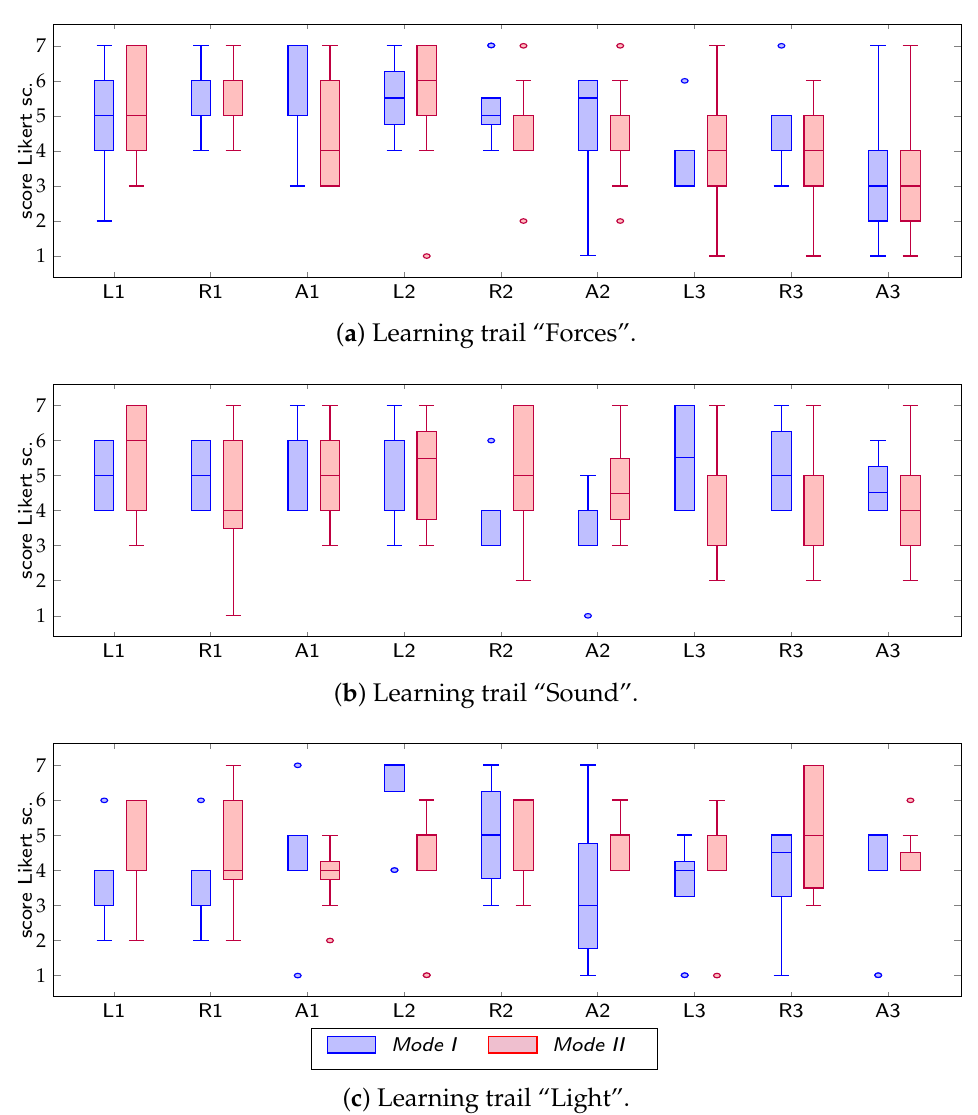
Figure 6. Group leader response scores for tests with three learning trails and the three stations i on a Likert scale for the variables for like L i , recommend R i and play again A i . The number of group leaders is n = 41 ( 14, 14, 13 ) ; n = 15 ( 5, 5, 5 ) for Mode I and n = 26 ( 9, 9, 8 ) for Mode II.